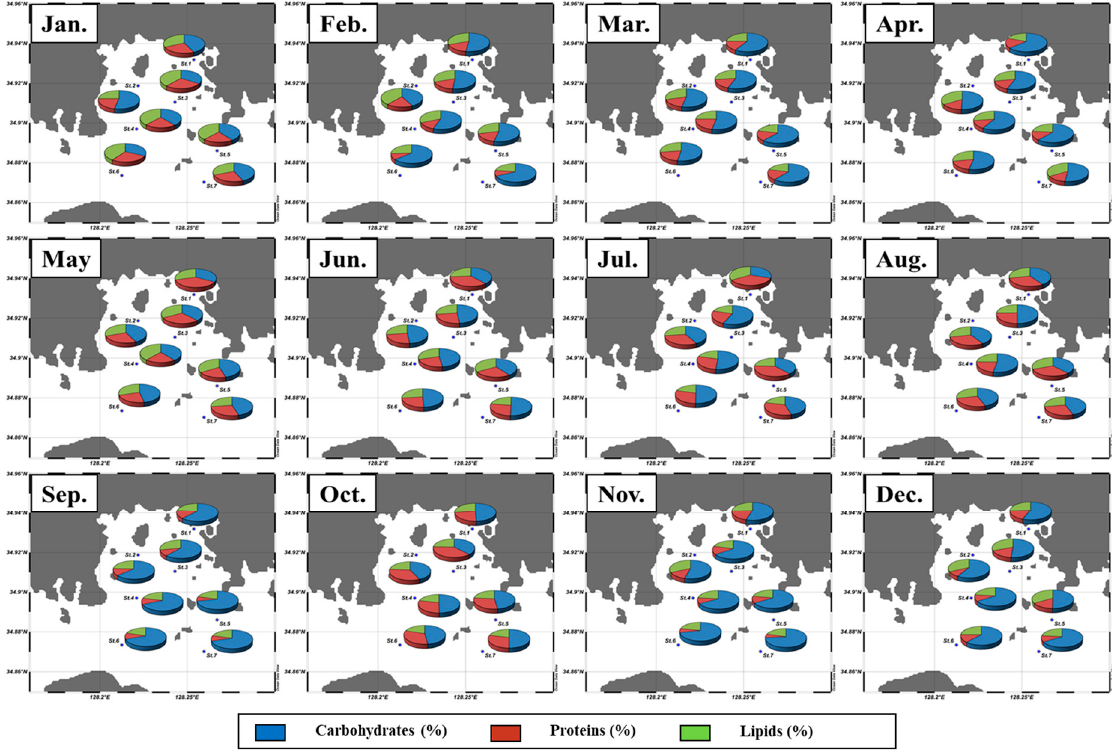
Figure 5. Biochemical compositions of POM relative to the total FM at the sampling stations in Jaran Bay.